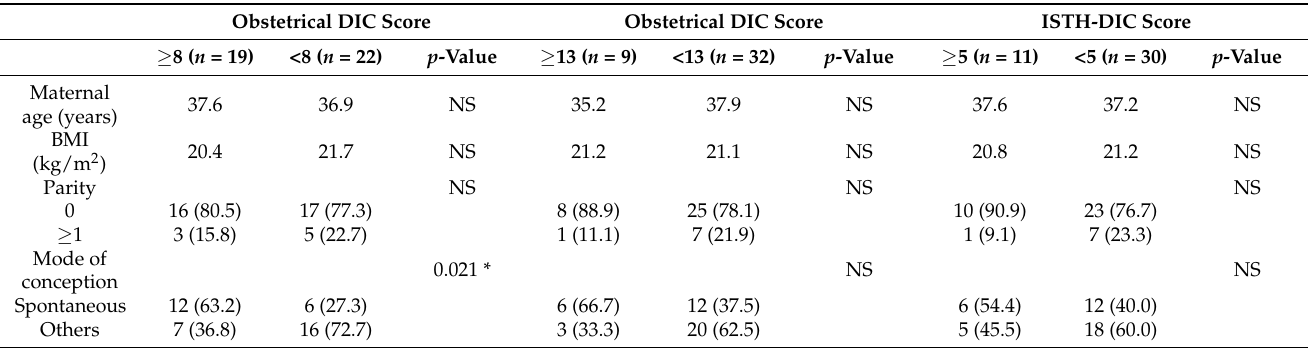
Table 3. Comparison of the characteristics of patients with or without